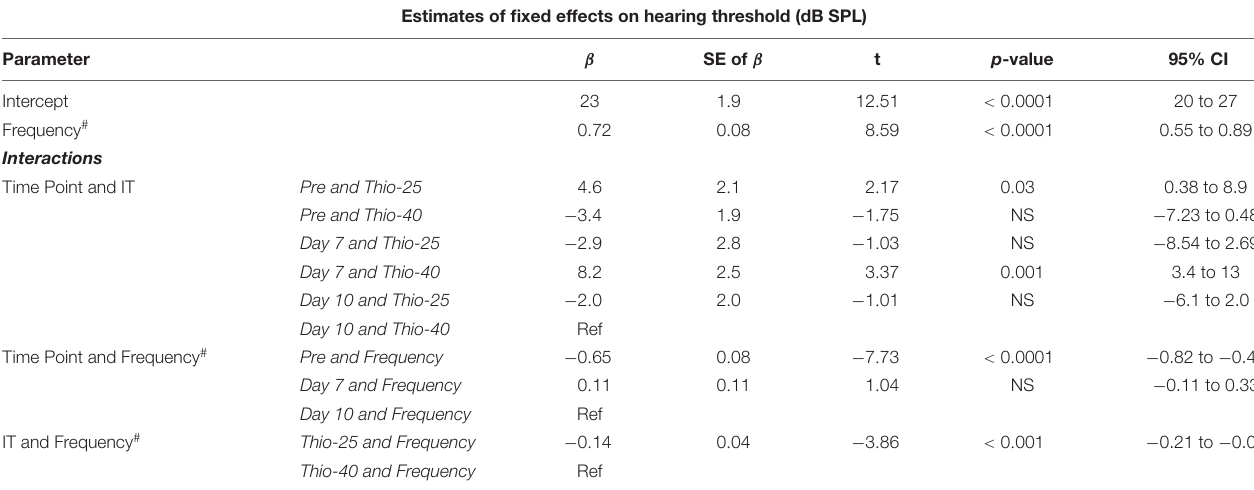
TABLE 1A | Mixed linear modeling of associations of the hearing thresholds presented in Figure 1 with IT administration, frequency, and time point. Estimates of fixed effects on hearing threshold (dB SPL)